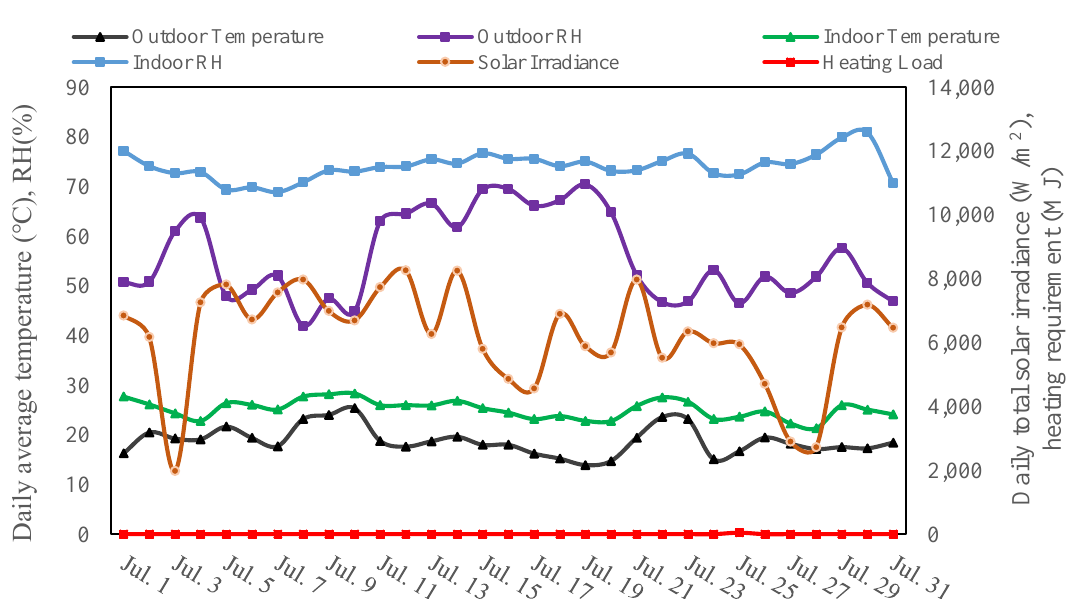
Figure 13. Daily average indoor conditions, solar irradiance, and heating loads in March.